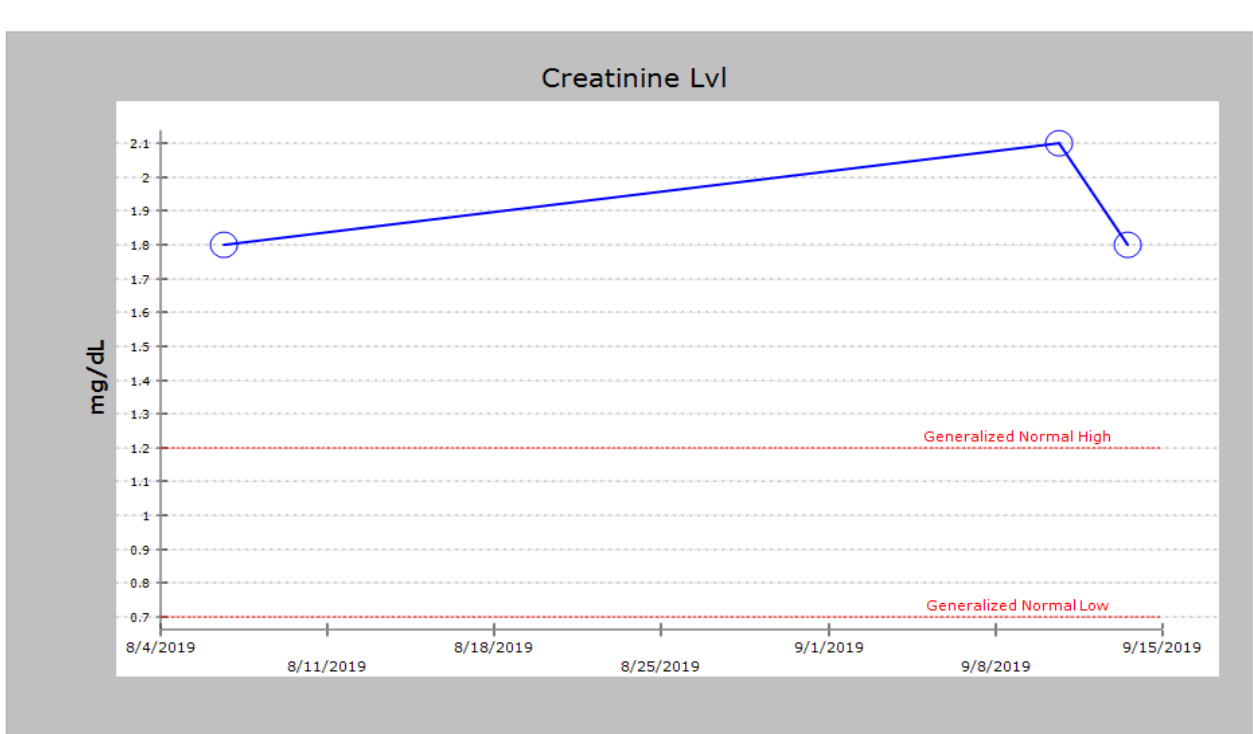
Figure 5. Graphical trend of platelet count.